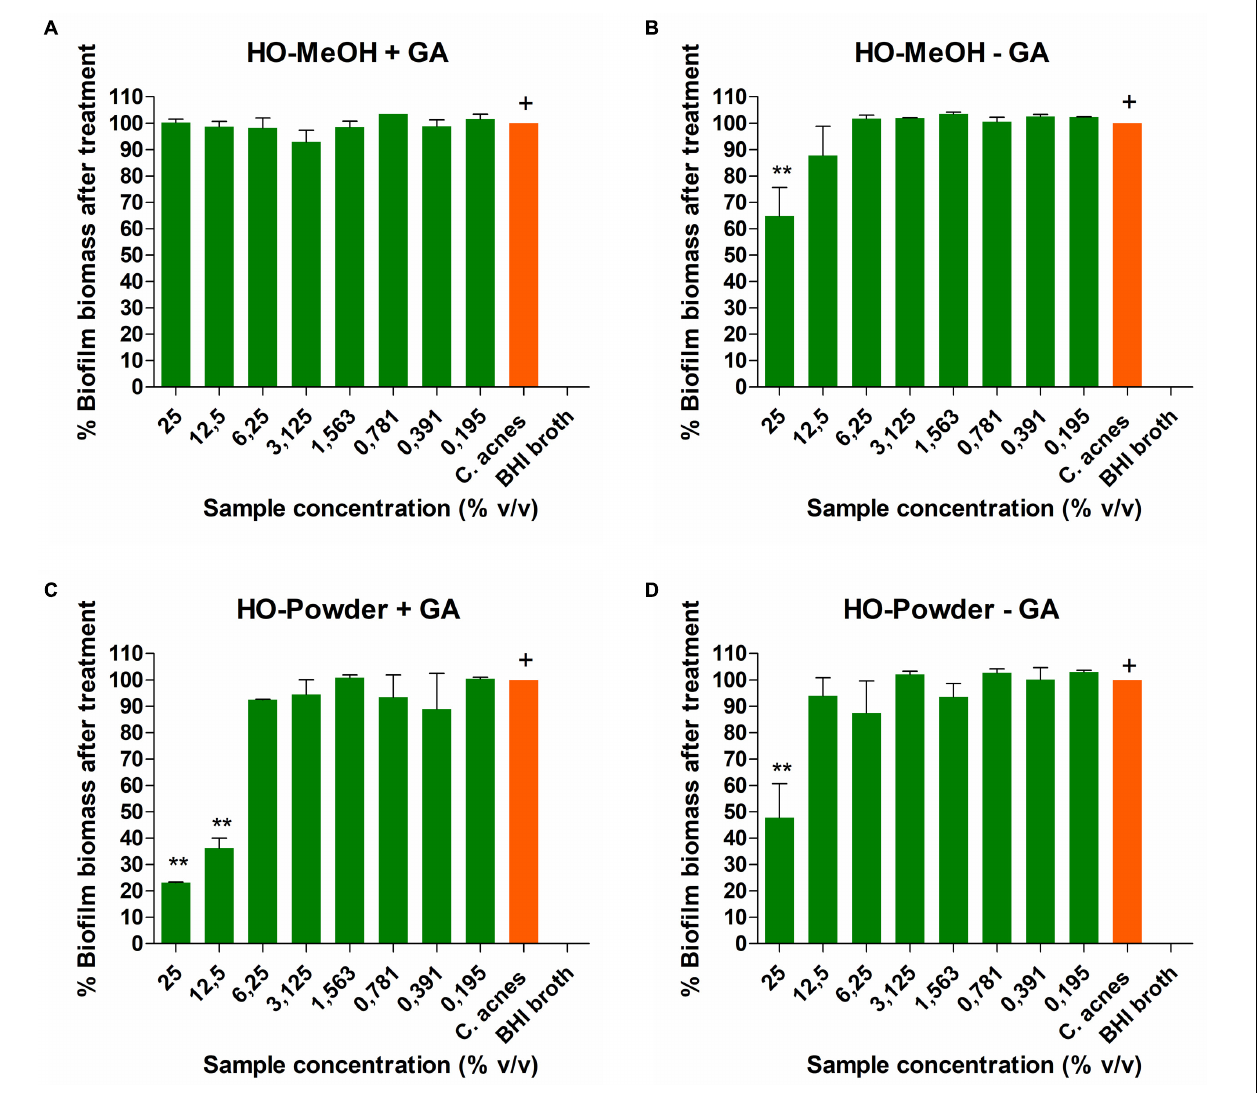
FIGURE 11 | Dose-dependent disruption of mature Cutibacterium acnes biofilm after 72 h by (A) Helichrysum odoratissimum methanol extract AuNPs + Gum arabic, (B) H. odoratissimum methanol extract AuNPs – Gum arabic, (C) H. odoratissimum leaf powder AuNPs + Gum arabic, (D) H. odoratissimum leaf powder AuNPs – Gum arabic compared to the untreated C. acnes control. ** Represents significance where p < 0.01, + represents the control to which all other samples were